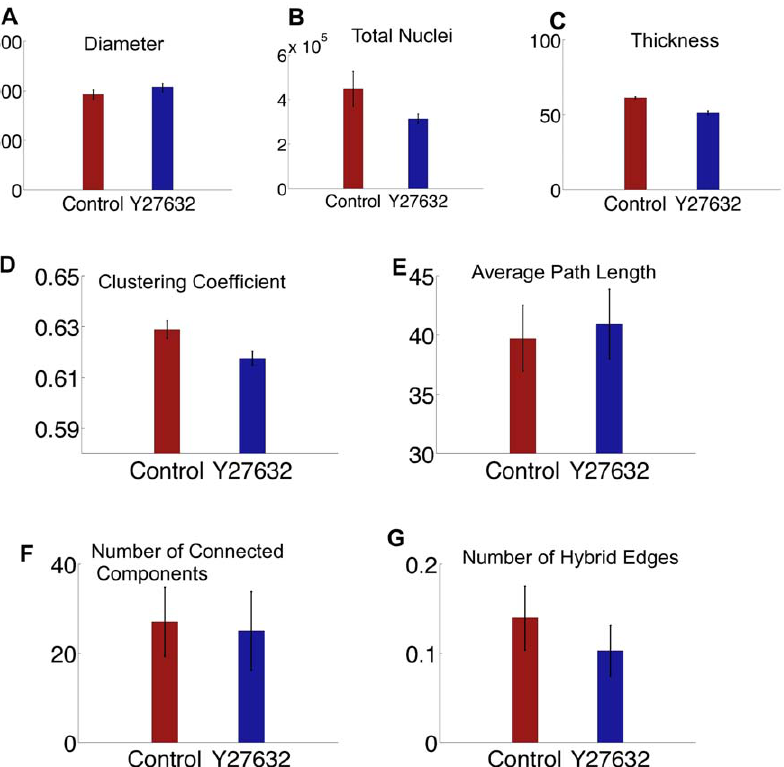
Figure 4. Indirect validations of cell-graph features using standard image analysis methods. Control refers to untreated epithelium and Y27632 treated epithelium. (a) Diameter of explants was measured using MetaMorph image analysis tools from single confocal images (b) Total nuclei were measured from single confocal images. (c) Thickness was measured from confocal Z-stacks of images. With Y27632 treatment, diameter of the explants increases and thickness and number of cells decreases thus reducing the overall compactness of the tissue structure. Cell-graph- derived features, such as clustering coefficient (d), average path length (e) and number of connected components (f) show that Y27632 treatment increases the distance between two cells, thereby lowering the number of linked cells and decreasing the overall compactness in the epithelial and mesenchymal regions.